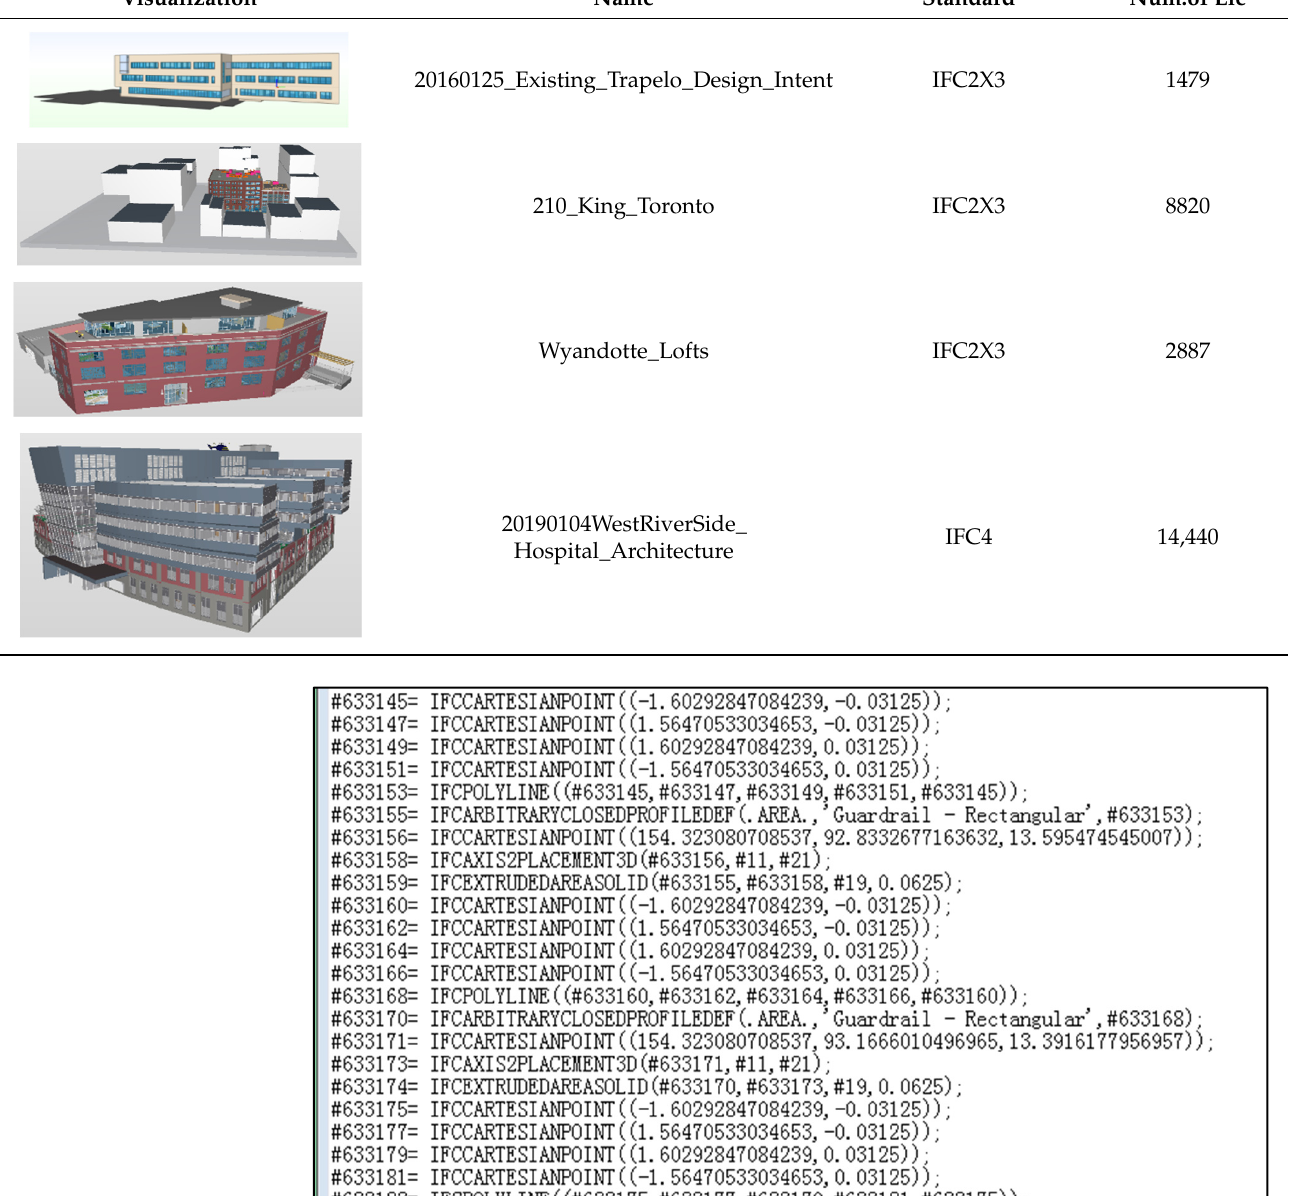
Table 1. Basic information of BIM.